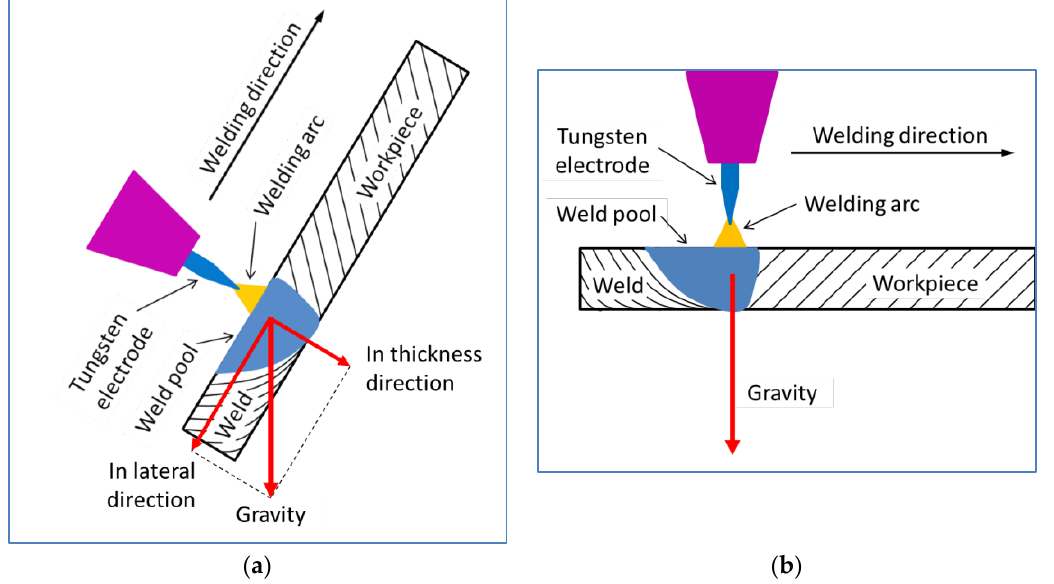
Figure 13. Orientations of weld pools relative to gravity for the two welding positions: ( a ) climbing